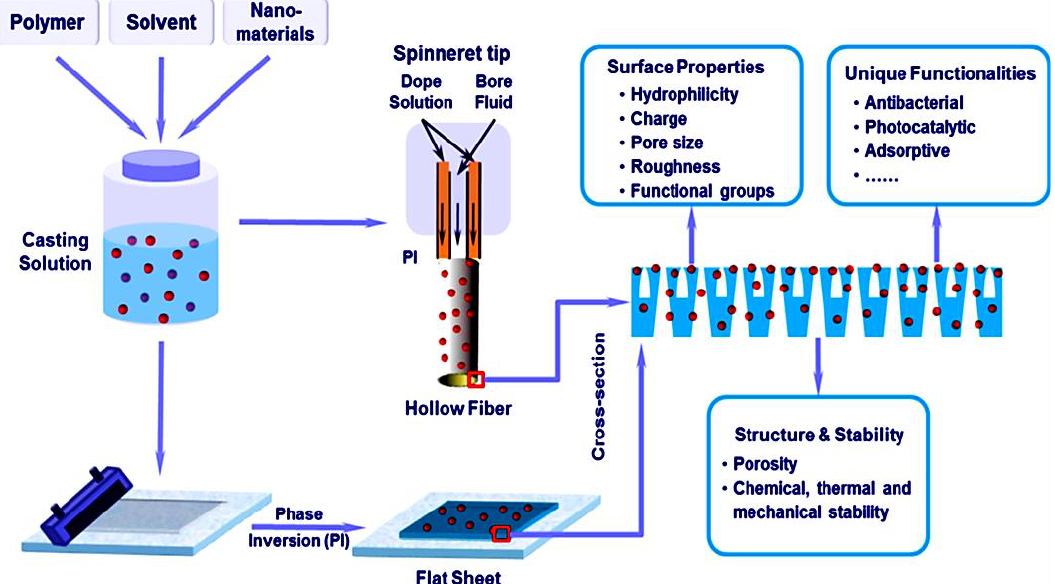
Figure 2. Fabrication of conventional nanocomposite membranes [130]. Reproduced with permission from Elsevier.